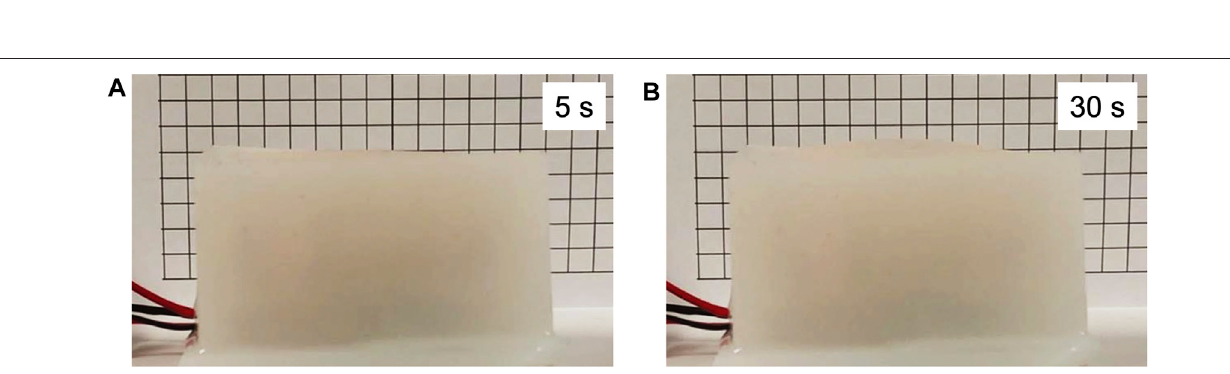
Frontiers in Robotics and AI |